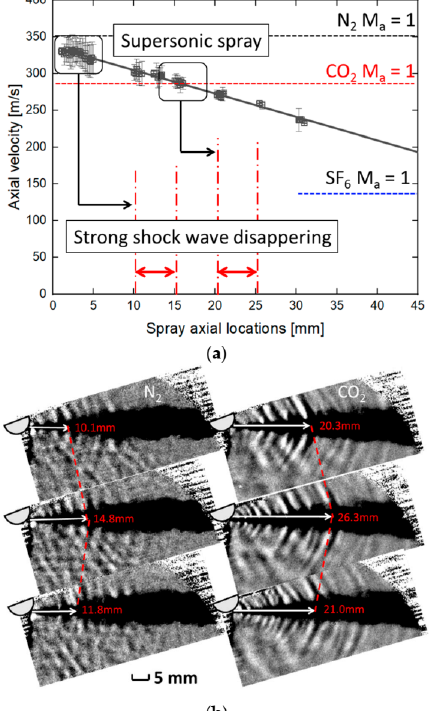
Figure 10. Spray velocity in axial axis ( a ); the shock-wave generation at steady state ( b ) and images timings from top to bottom: 1.100, 1.125, 1.150 ms; ambient gas conditions: 297 K and 9.0 kg / m 3 ; injection pressure: 65 MPa.